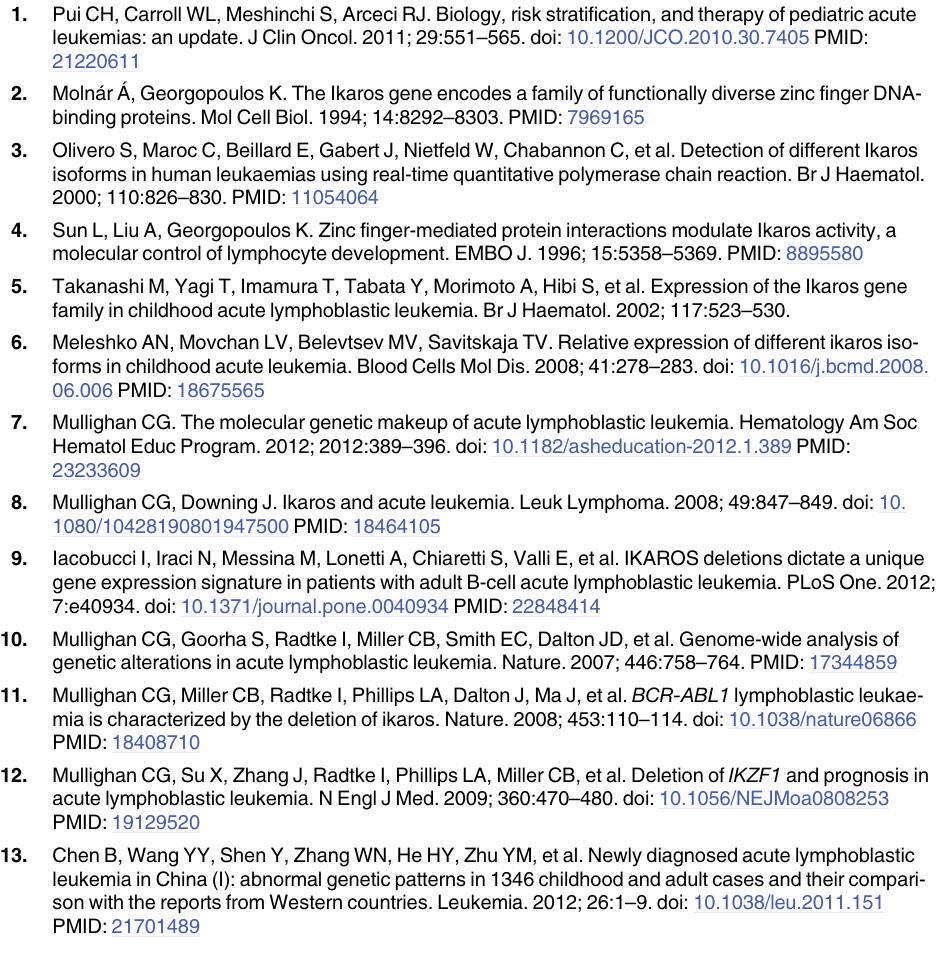
S3 Fig. Survival analysis according to risk group. The Kaplan Meier curves for EFS (a & b), RFS (c & d) and OS (e & f) show that the patients classified into standard (a, c & e) and high (b, d & f) risk groups expressed Ik6 and/or Ik8 (solid black line) and others Ikaros isoforms (dotted black line). No statistically significant difference was found, but the expression of the domi- nant-negative isoforms tended to decrease OS in both groups.